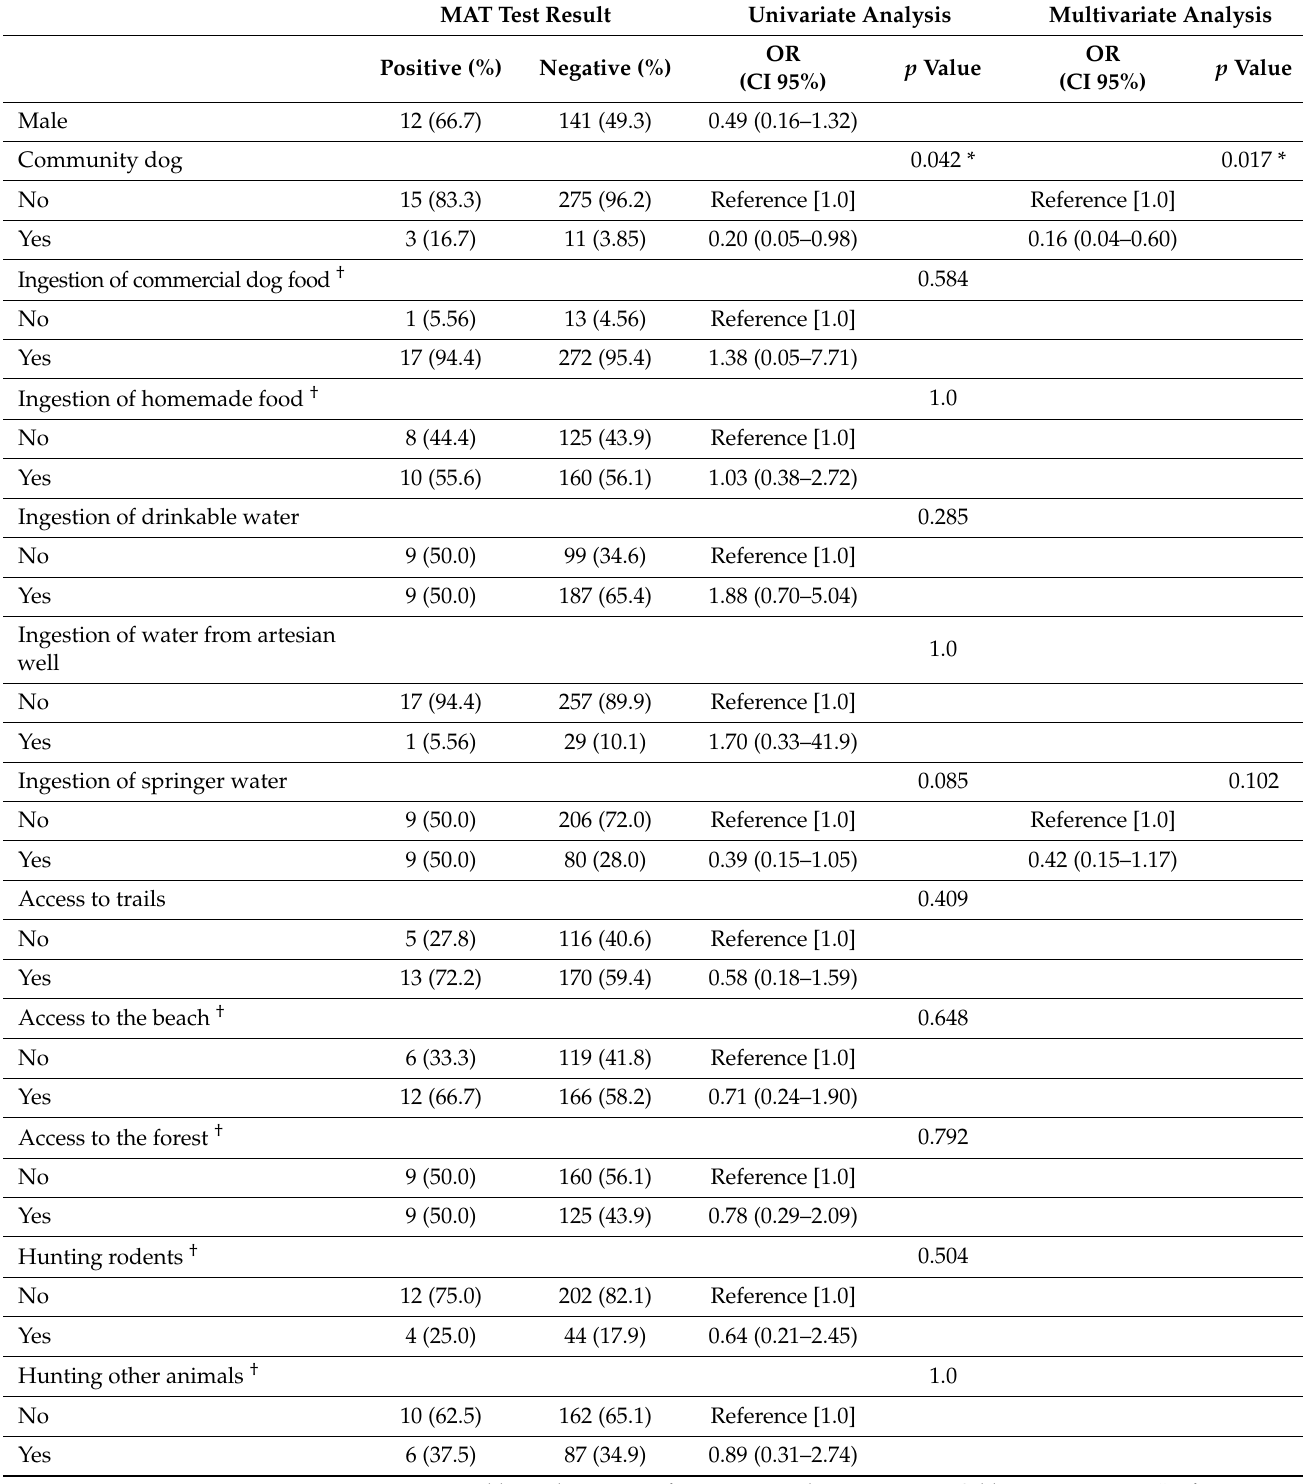
Table 1. Cont. MAT Test Result Univariate Analysis Multivariate